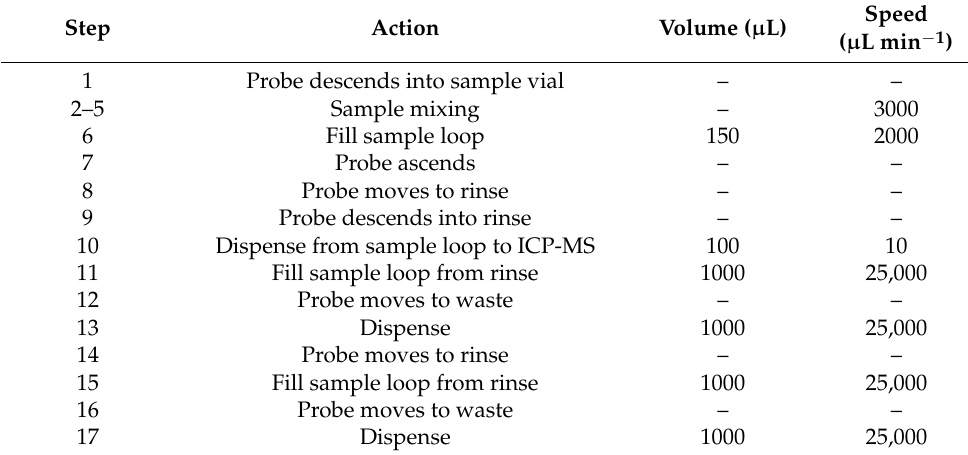
Figure 1. Illustration of the single particle (SP)-ICP-TOF-MS setup. Table 2. Autosampler sample introduction procedure.